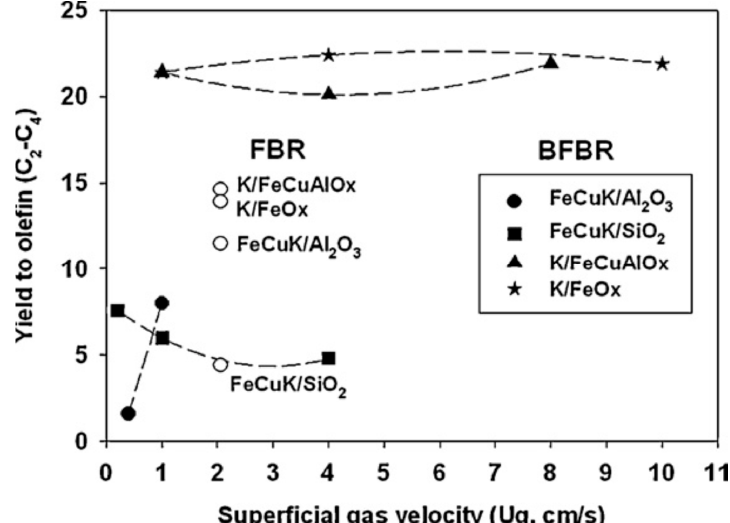
Figure 24. The yield to C 2 –C 4 olefin with respect to the superficial gas velocity in a fixed bed reactor (FBR) and a bubbling fluidized bed reactor (BFBR). Reprinted with permission from [111]. Copyright (2011) Elsevier Science BV, Amsterdam, The Netherlands.